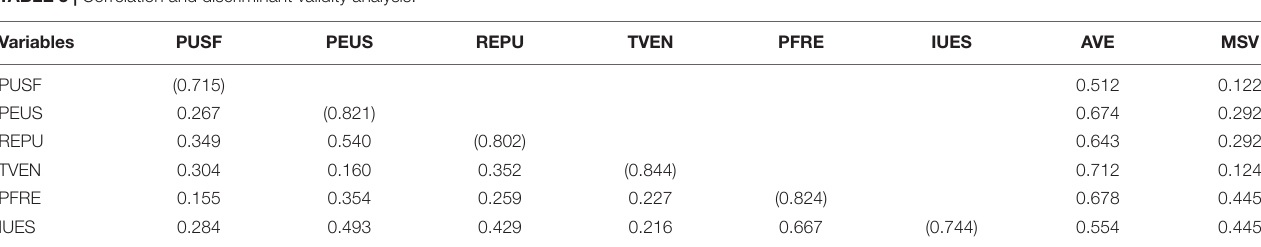
TABLE 3 | Correlation and discriminant validity